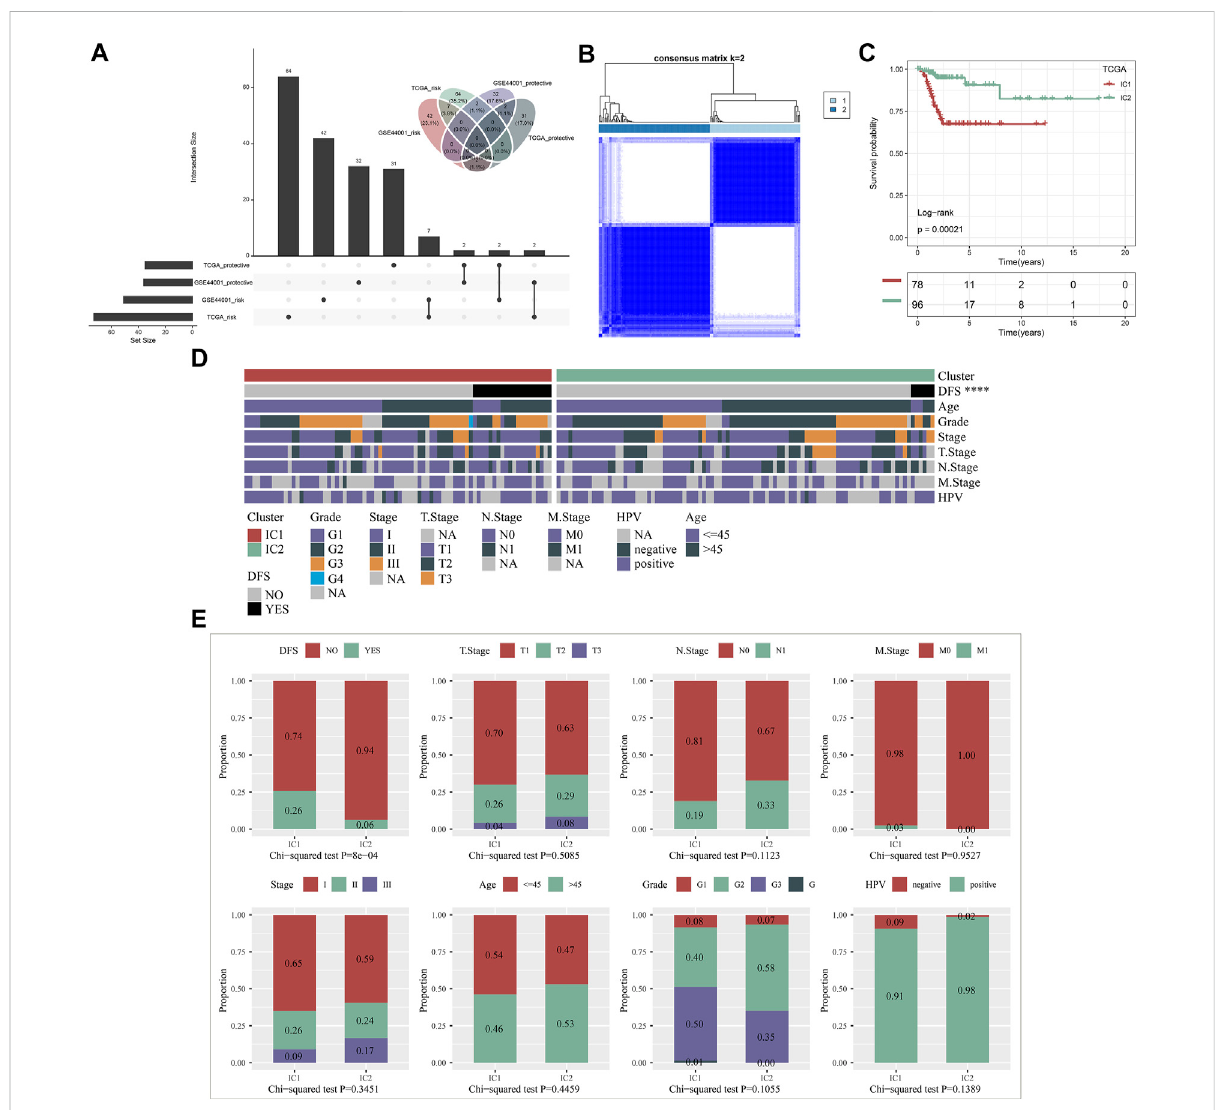
FIGURE 1 Construction of immune subtypes for cervical cancer with different recurrence outcomes based on recurrence-related IRGs in the TCGA dataset. (A) Univariate cox regression analysis of protective factors and risk factors for cervical cancer recurrence among IRGs in the TCGA and GSE44001 datasets. (B) Consensus matrix heatmap of cervical cancer samples based on the expression pro fi ling of recurrence-related IRGs when k = 2. (C) Kaplan-Meier curves of DFS between IC1 and IC2 in the TCGA dataset. (D) Landscape of clinicopathological parameters in